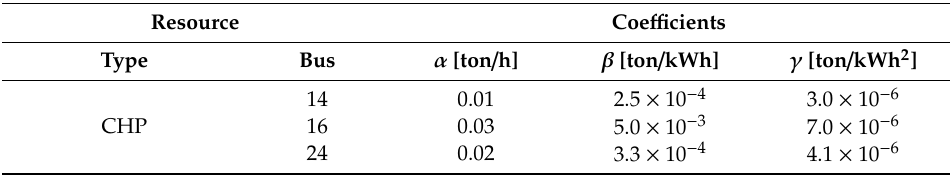
Table A2. Parameters used in the NSGA-II